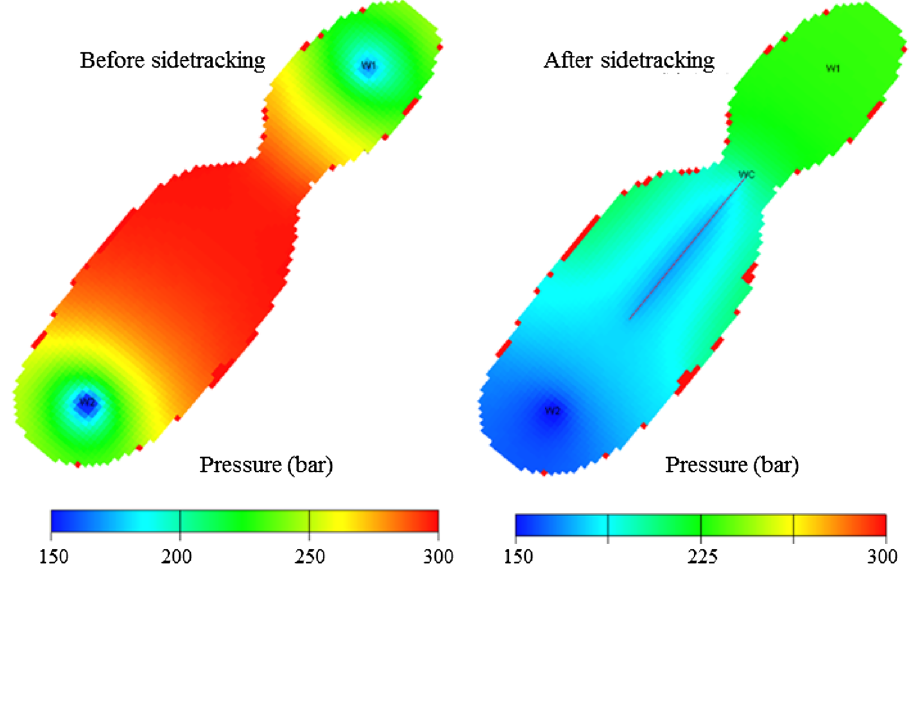
Fig. 8 Pressure conformance status before and after sidetrack- ing (old gas well cumulative production rate when side- tracked is 1500 × 10 4 m 3